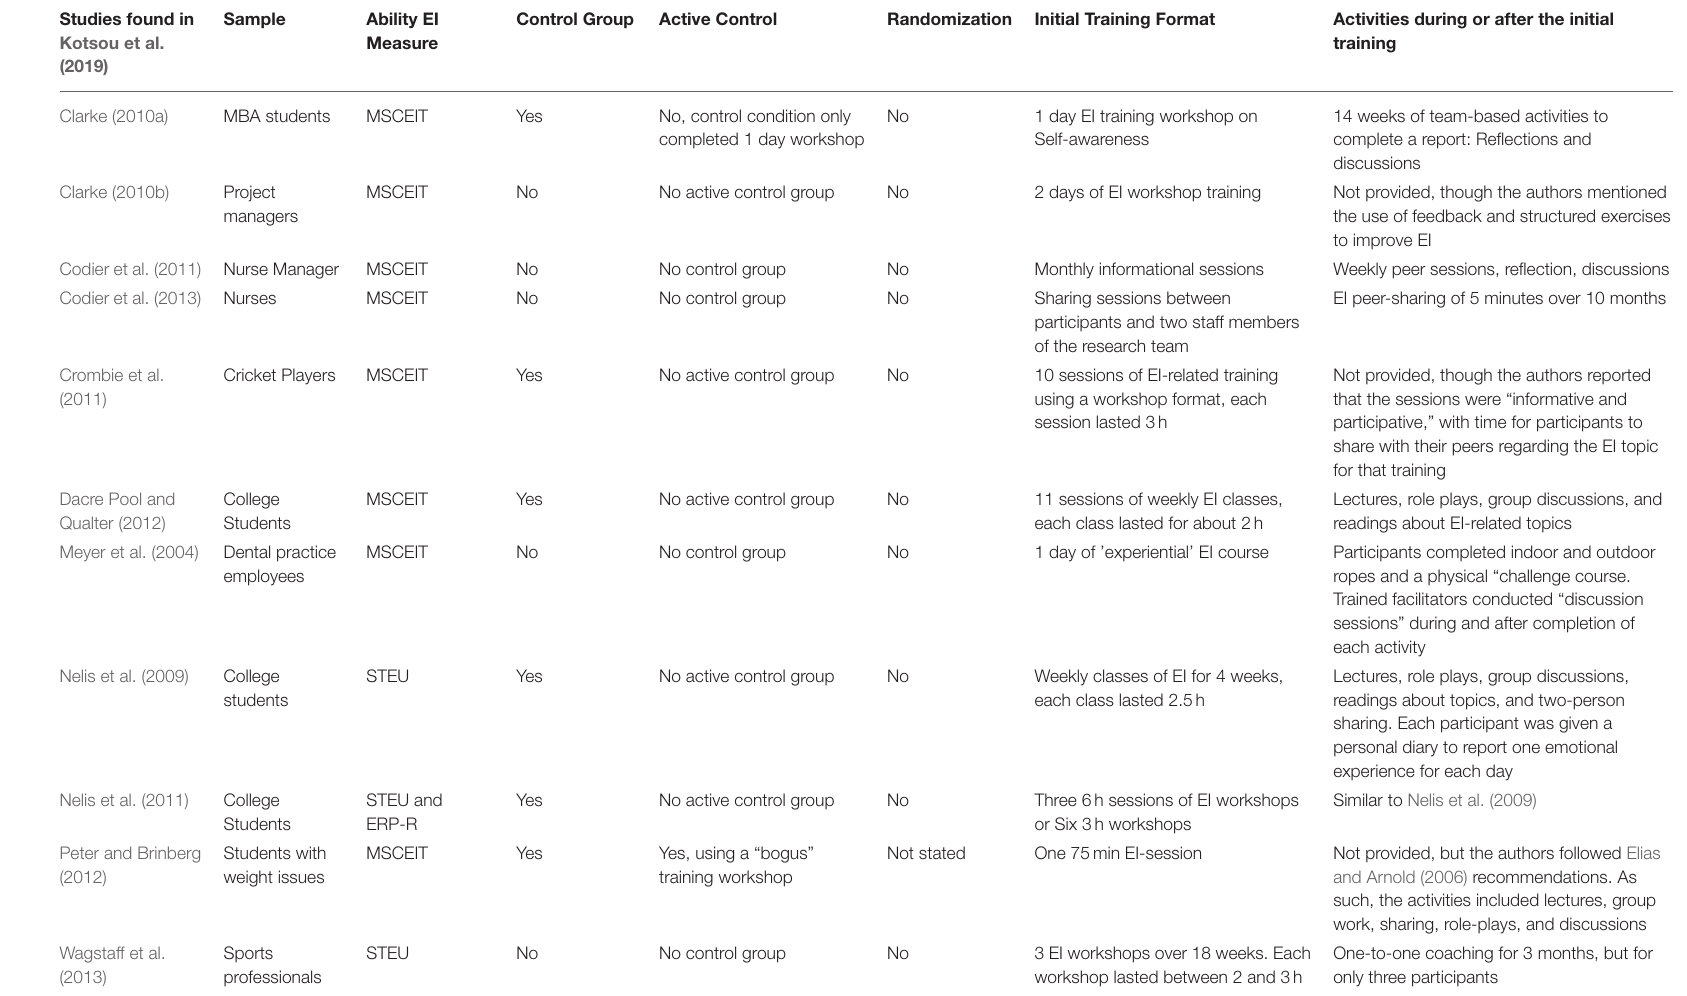
TABLE 1 | Overview of ability emotional intelligence training studies used in the present narrative review. Studies found in Kotsou et